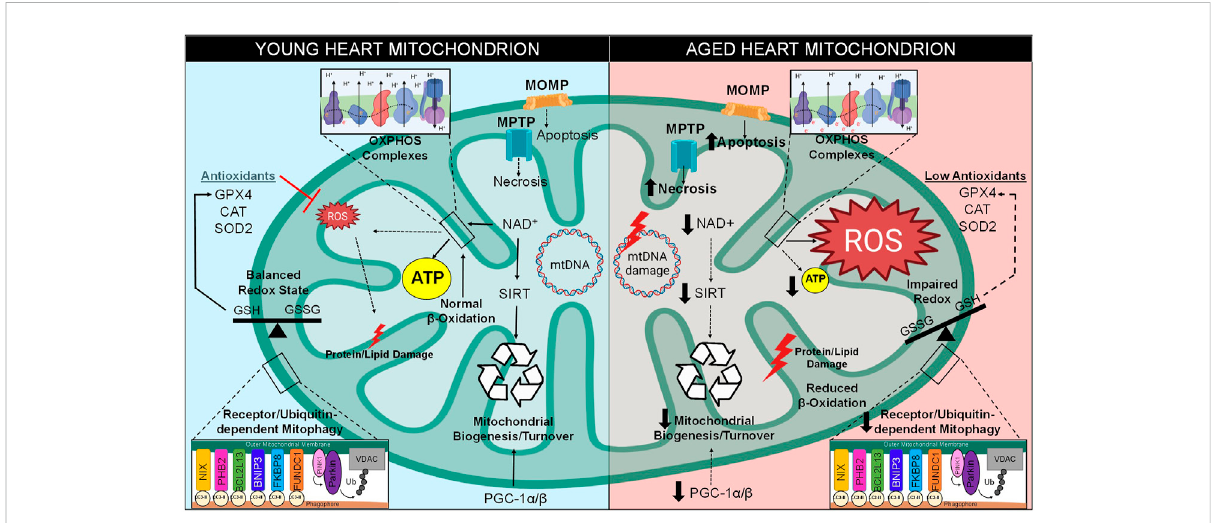
FIGURE 2 Mitochondrial Dysfunction in Aging. There are various intracellular pathways that become altered over time, especially with regard to mitochondrial function. Between the stages of young and late adulthood, mitochondria within the cardiomyocytes experience a decreased level of biogenesis due to decreased expression of PGC-1 and downregulation of NAD + -dependent sirtuins. A metabolic shift occurs in old hearts, resulting in greater glucose and less fatty acids utilization for energy production. Mitochondrial quality control by mitophagy induction is also compromised. Cell death levels increase in the form of apoptosis and necrosis, which utilize mitochondrial outer membrane permeabilization (MOMP) through the Bcl-2 family and mitochondrial permeability transition pore (MPTP), respectively. Excess ROS is generated through increase electron transport chain (ETC) leak, resulting in increased levels of mitochondrial DNA (mtDNA) damage, imbalance of CM redox states, damage to lipids/proteinswithinthemitochondria,andtheinability ofantioxidants toclear ROSfromthemicroenvironment.Together,thesestressorsleadtoa decrease in mitochondrial function and lower levels of ATP